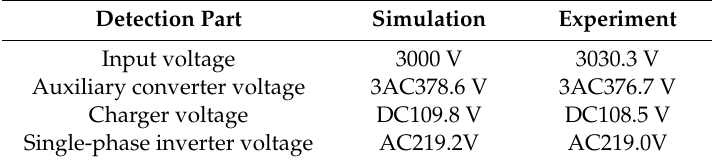
Figure 22. Results under rated load conditions.